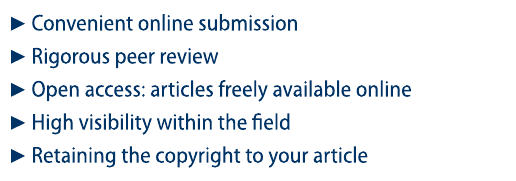
Data are expressed as median [interquartile range] or n (%) BSI bloodstream infection, ICU intensive care unit